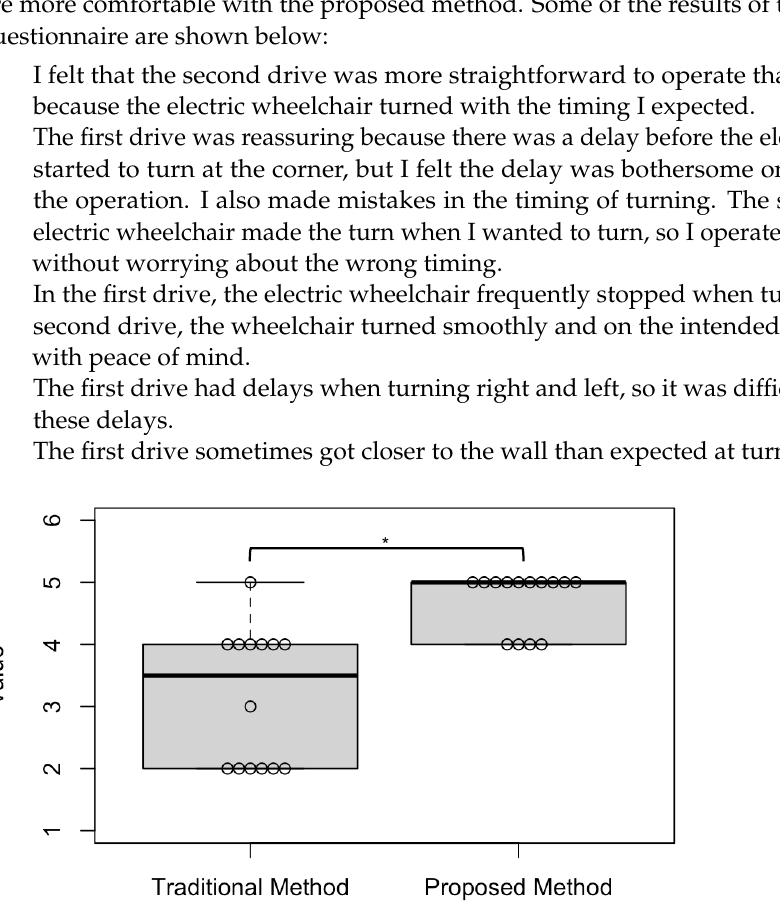
Figure 12. Box-and-whisker diagram of subjective evaluation. * The bold line in each box represents the median value of the score. The bottom side of the box represents the lower quartile, and the top side indicates the upper quartile. The whisker extending from the box indicates the maximum value that is not considered an outlier. The circles in each box indicate the number of subjects who scored